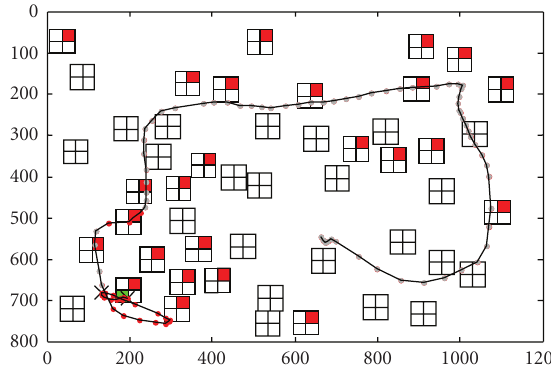
Figure 11: A single search trajectory in the presence of 48 distractors using